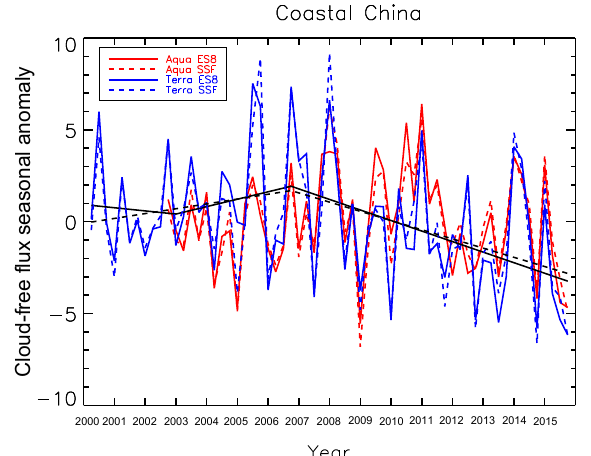
Figure 11. The deseasonalized, seasonally averaged cloud-free fluxes over coastal China derived utilizing the collocated MODIS– CERES (SSF/ES-8) datasets. Straight lines show piecewise linear fits for the study periods of 2000–2015 (Terra only).